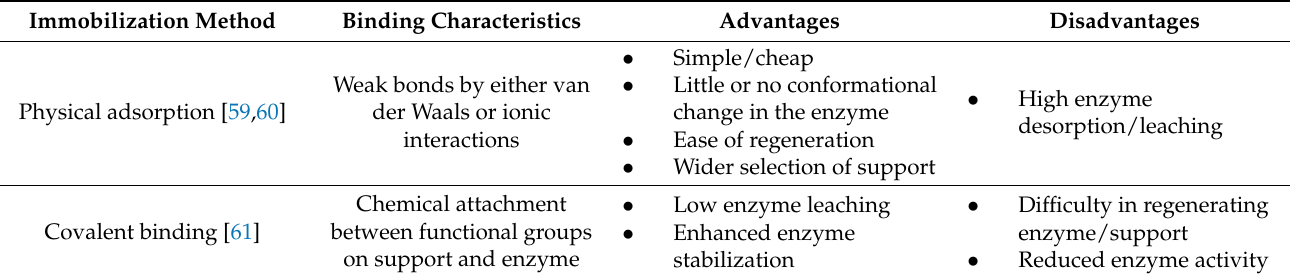
Table 3. Summary of conventional immobilization